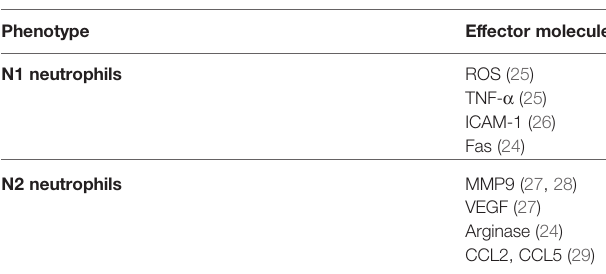
TABLE 1 | Neutrophil